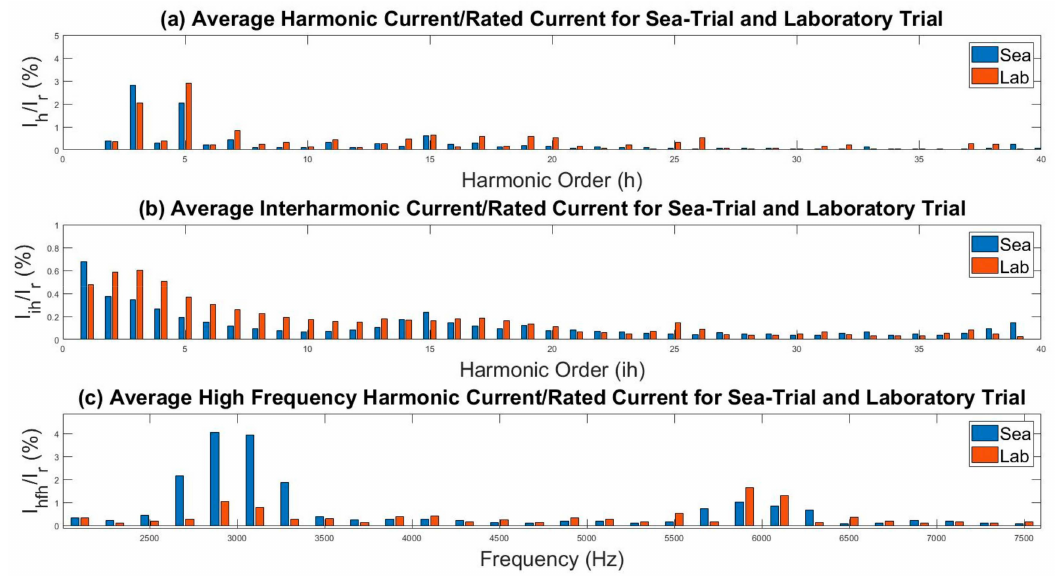
Figure 12. Average normalised harmonic currents observed during sea trial and laboratory trial